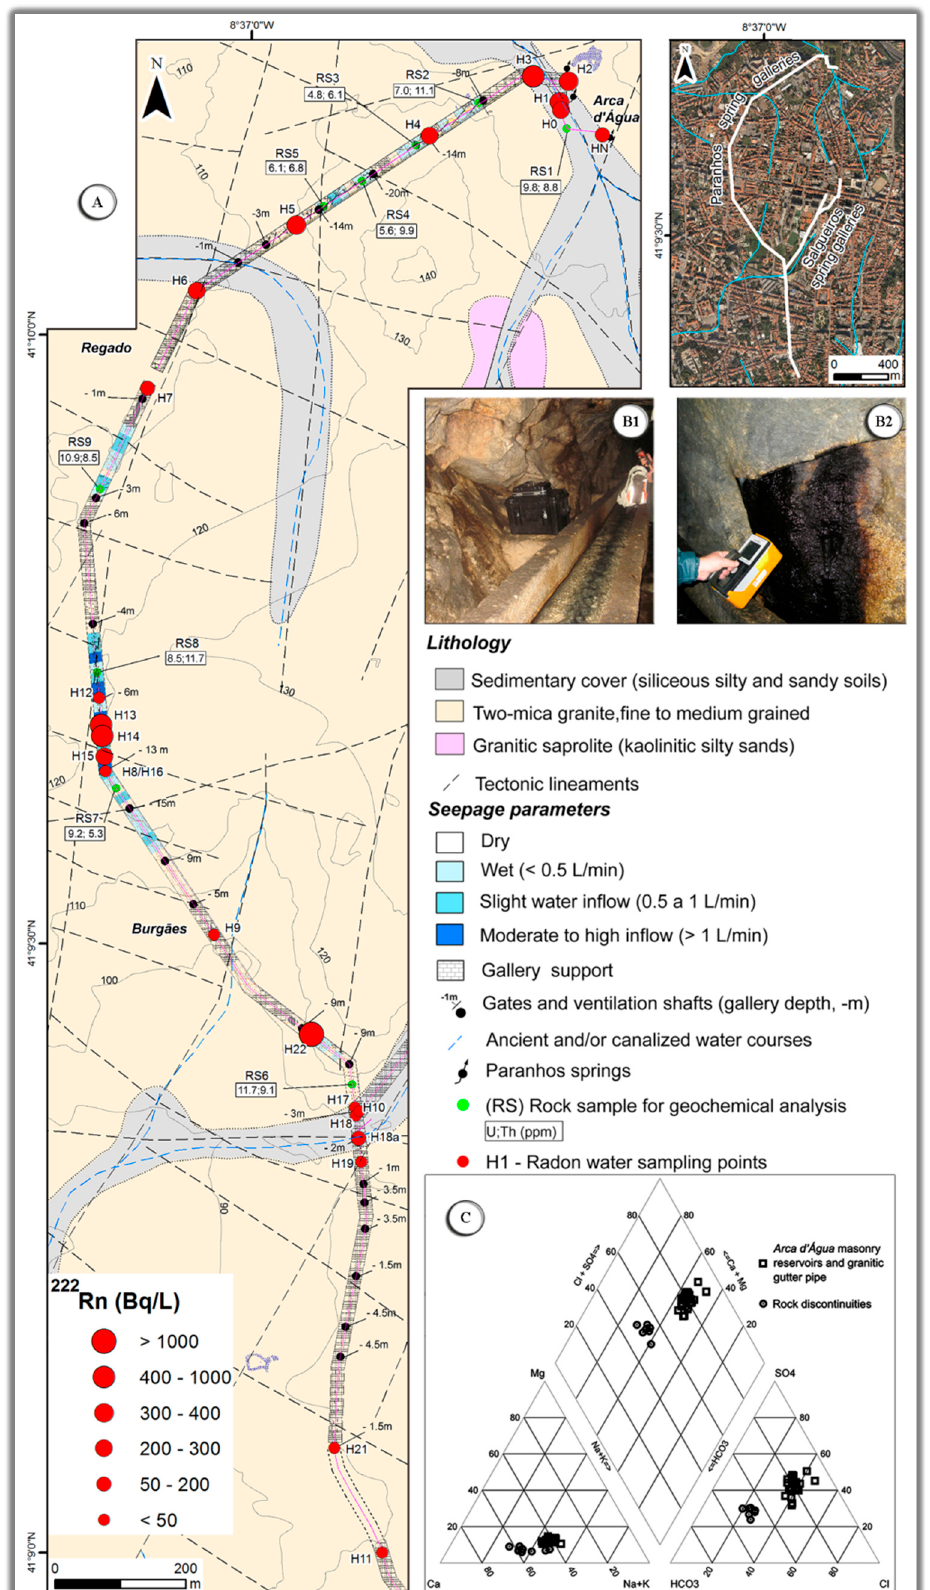
Figure 4. Groundwater radon concentrations ( A ); granitic gutter pipe ( B1 ); water flow from a granitic fracture covered by black ferromanganese biomineralisations ( B2 ); and hydrogeochemical facies ( C ) of Paranhos and Salgueiros waters.